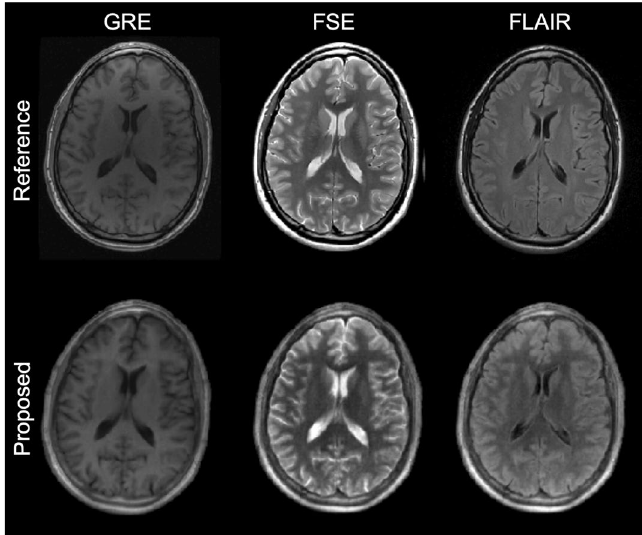
Figure 11. Contrast-synthesis. The inclusion of PD to the inferred parameters enables high-quality contrast-